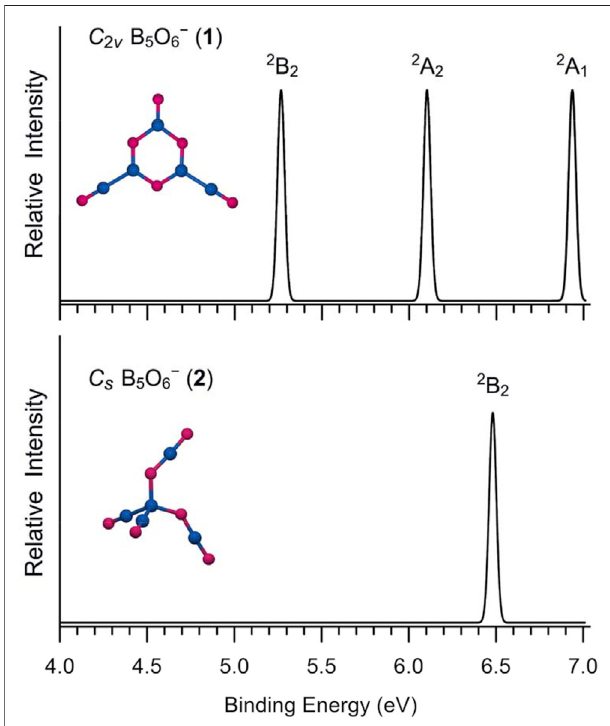
FIGURE 6 | Simulated photoelectron spectra of anionic B 5 O 6 − (1) and B 5 O 6 − (2) clusters at the time-dependent PBE0/6-311+G(d) (TD-PBE0)